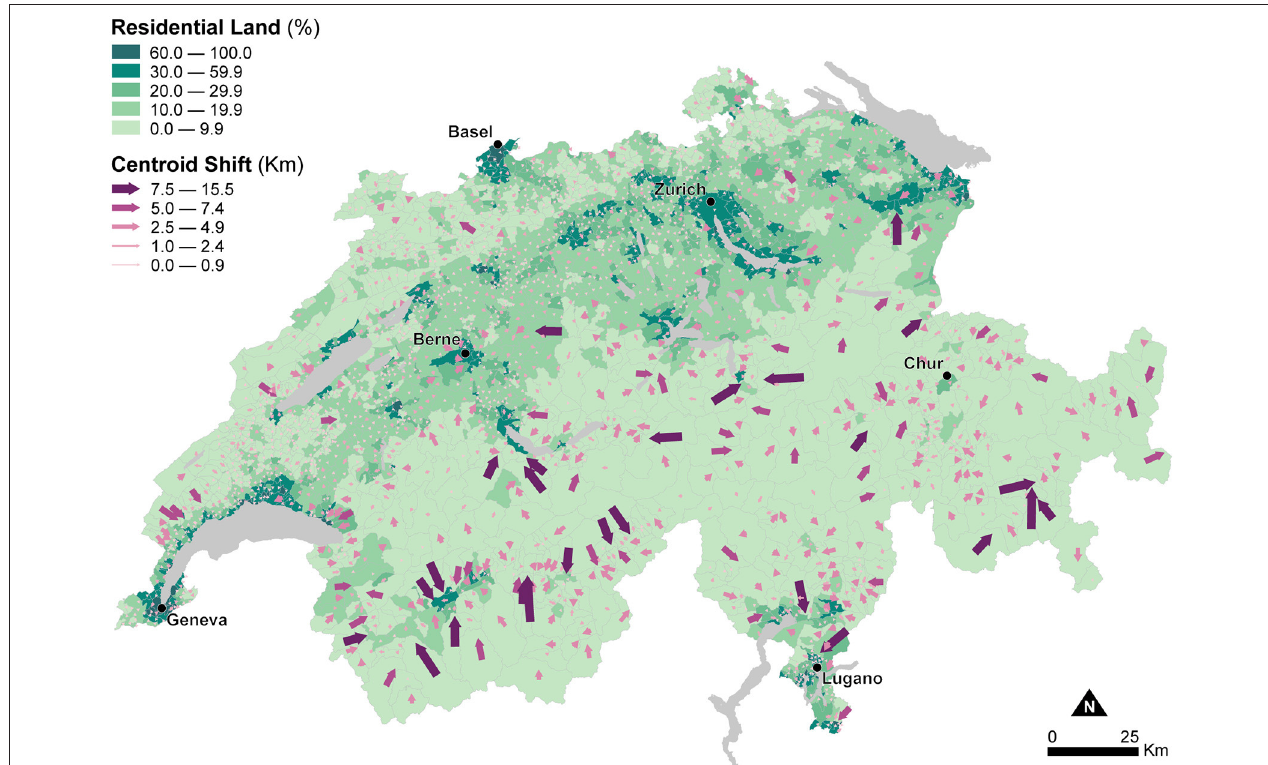
FIGURE 2 | Effects of dasymetric refinement of the municipal units — changes of spatial extent (part of residential land) and centroid displacements (shift to the centroid of the residential land). The data is classified according to the fixed classes classification method.